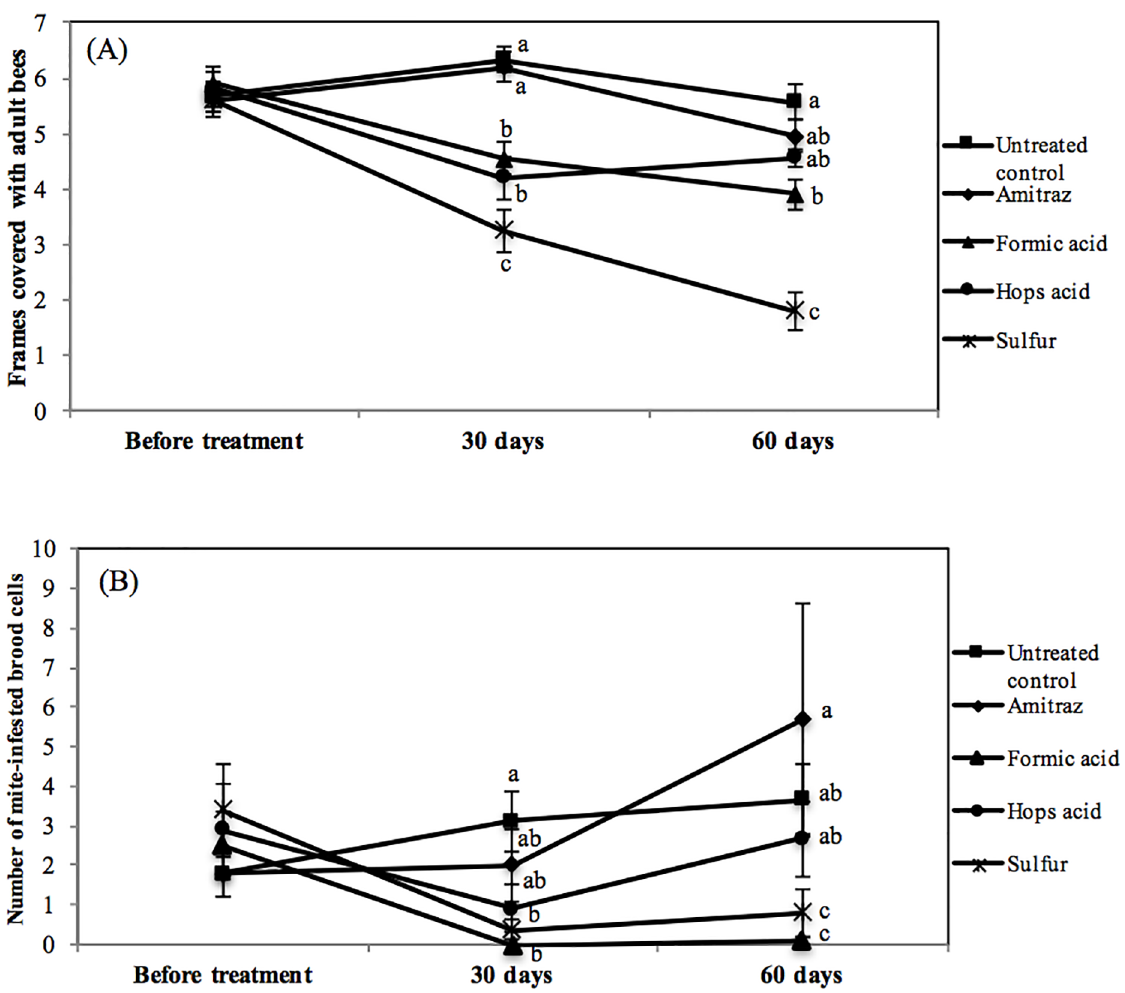
Fig 1. Average(mean ± SEM) number of frames covered in adult bees (A) and number of Tropilaelaps -infested cells observed by uncapping 100 sealed brood cells (B) from honey bee colonies treated with four different mite control products and untreated controls in the wet season. Treatment period was ca. 30–45days dependent upon control product. Letters indicatesignificantdifferencesbetweentreatment means (ANOVA, P < 0.05).